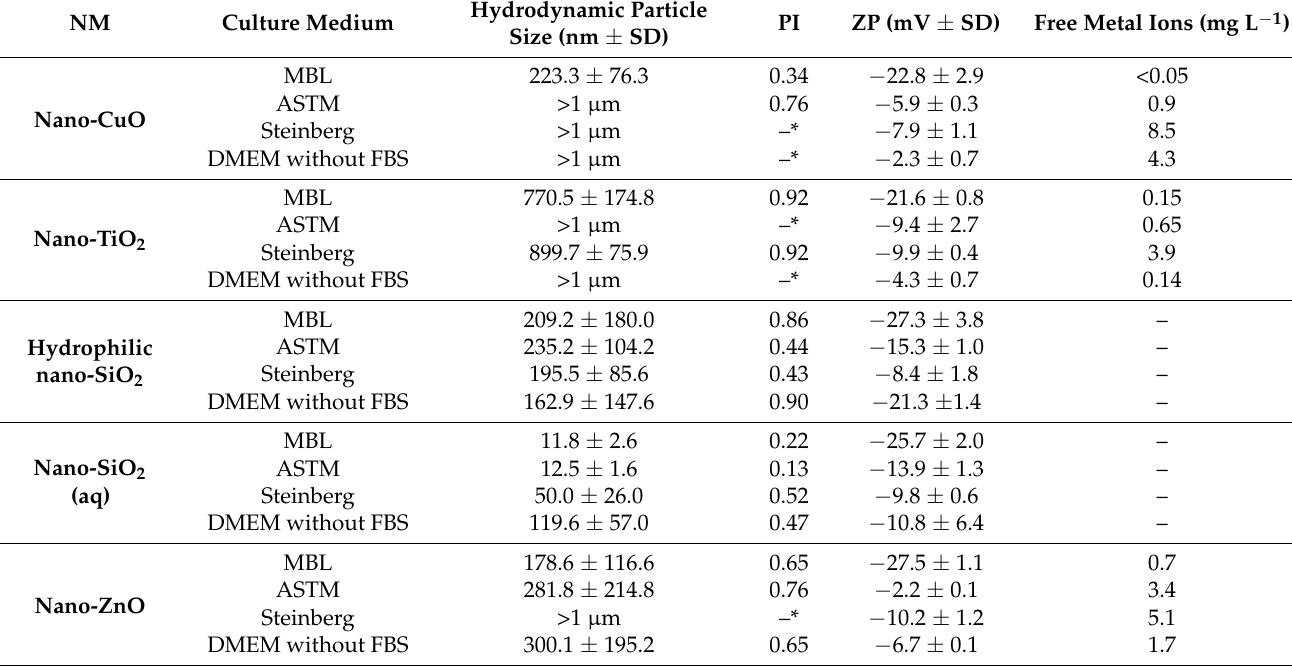
Table 1. Average hydrodynamic size ± standard deviation (SD), polydispersity index (PI), average zeta potential (ZP ± SD) and concentration of the free metal ions recorded in the nanomaterials (NM) dispersions prepared in different culture media at 20 mg L − 1